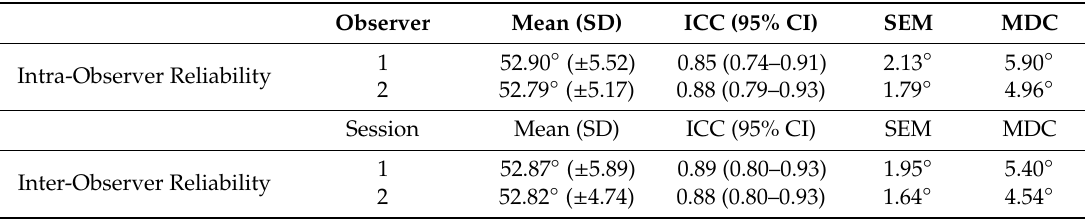
Table 2. Intra- and inter-observer